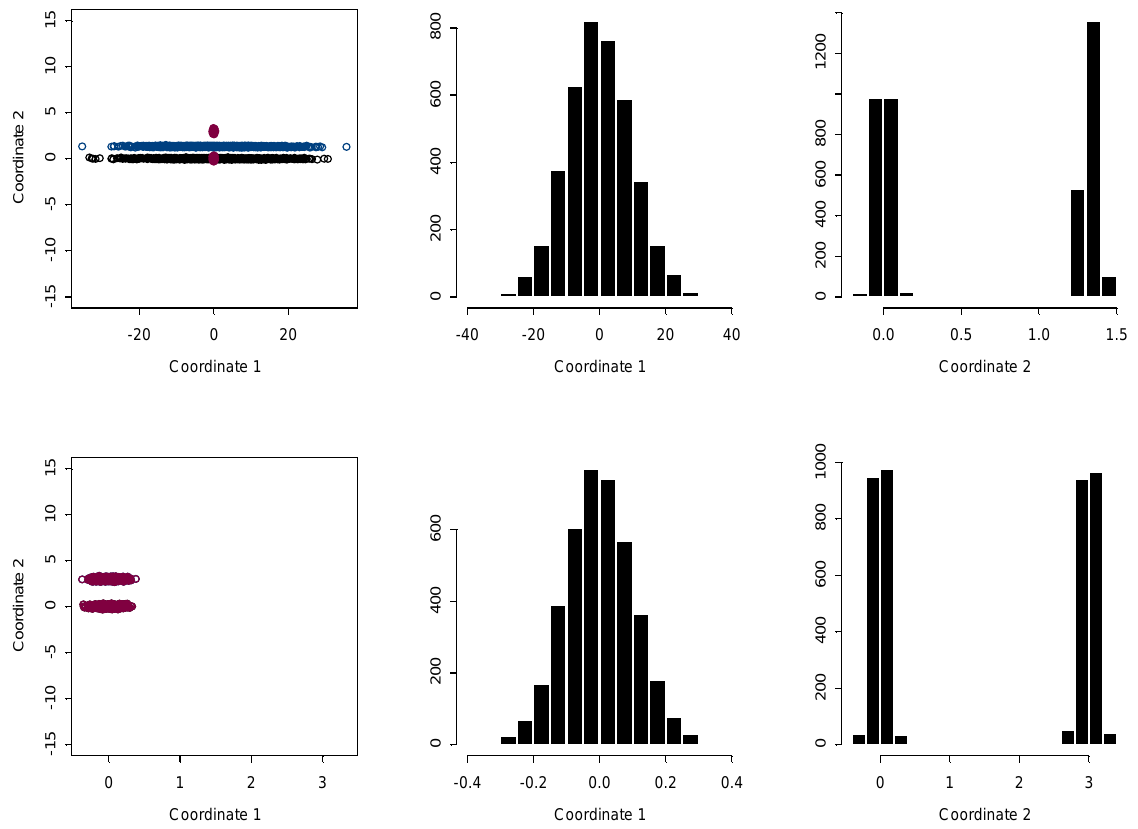
Figure 6 . (top left) A 2-component Gaussian (a mixture) characterized by two small circular point clouds; (top center) the first component of the GLS transform; (top right) the second component of the GLS transform. The bottom left plot is the same as the top left plot except the horizontal axis is scaled differently. The bottom center and right plots are the same as the corresponding plots in the top row, except are for the CLS